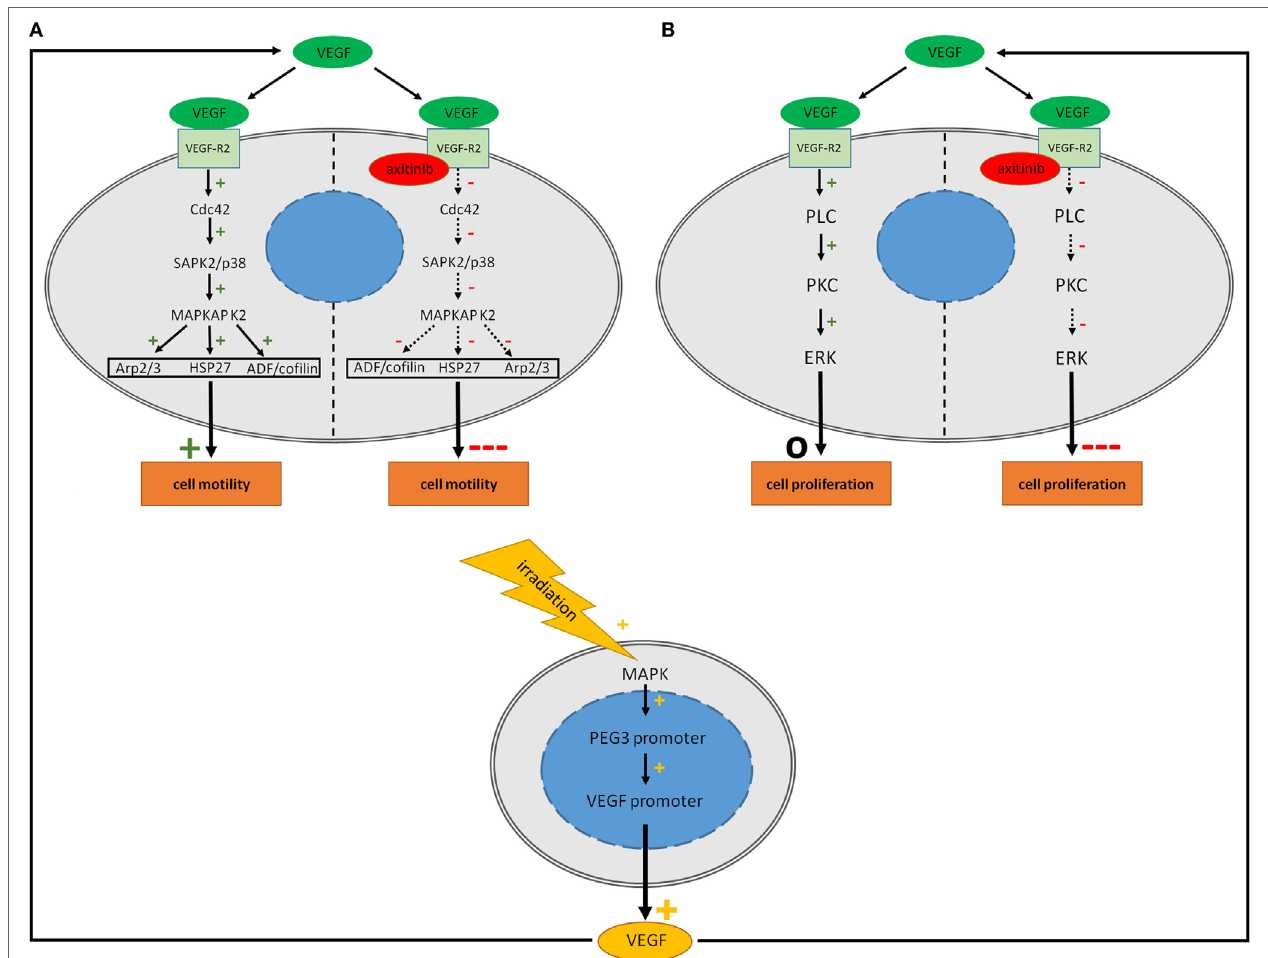
FigUre 4 | Potential signaling in human glioblastoma cell lines after treatment with vascular endothelial growth factor (VEGF), irradiation and axitinib. VEGF activates multiple pathways including the Cdc42 and PLC pathways concerning cell migration and proliferation. It is supposed that stimulating effects of irradiation are mediated via enhanced synthesis of VEGF. Irradiation elevates VEGF biosynthesis of glioblastoma multiforme cells via MAPK activation. (a) Activation of the Cdc42 pathway by VEGF leads to an increased activation of Arp 2/3, HSP27, and ADF/cofilin resulting in an enhanced motility. Blockade of the VEGF-R2 by axitinib might decrease the activation of the Cdc42 pathway due to theoretical consideration resulting in a crucial decreased cell motility. (B) VEGF activates the PLC pathway which is involved in cell proliferation while axitinib might deactivate this pathway with impairment of cell proliferation. While motility is increased by VEGF, no positive effect on proliferation could be observed. This might be due to fully activated VEGF-pathways even under control conditions. Continuous arrows: evidence of the effect, dotted arrows: assumption of the